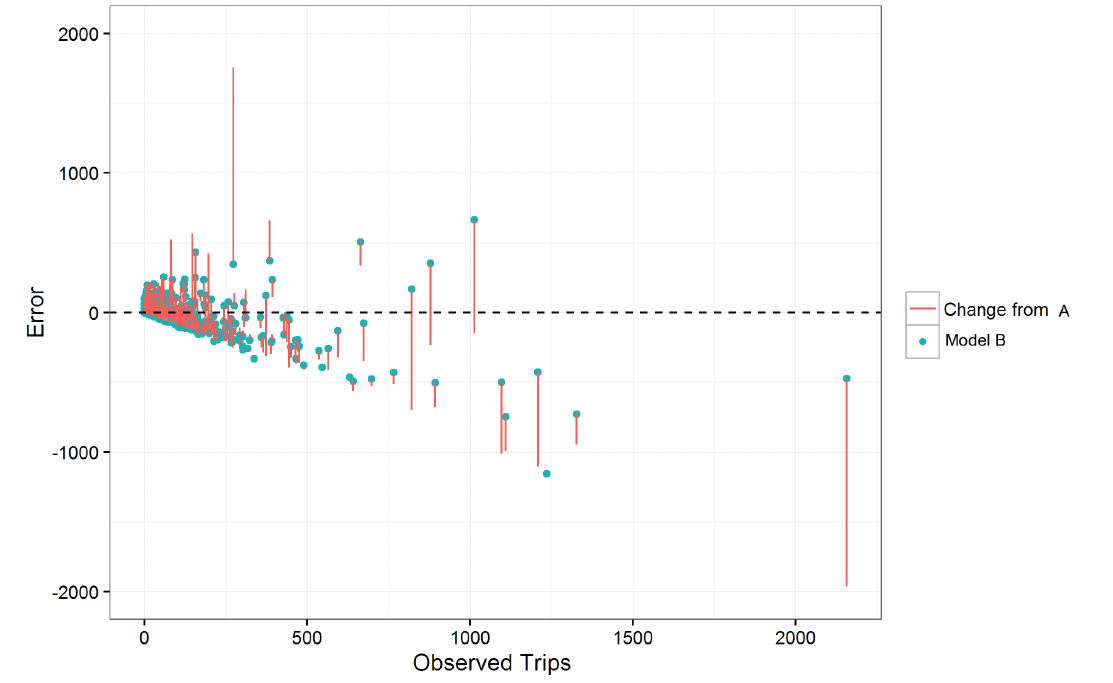
Figure 3. Effect of adding Foursquare variables in model B on leisure trip